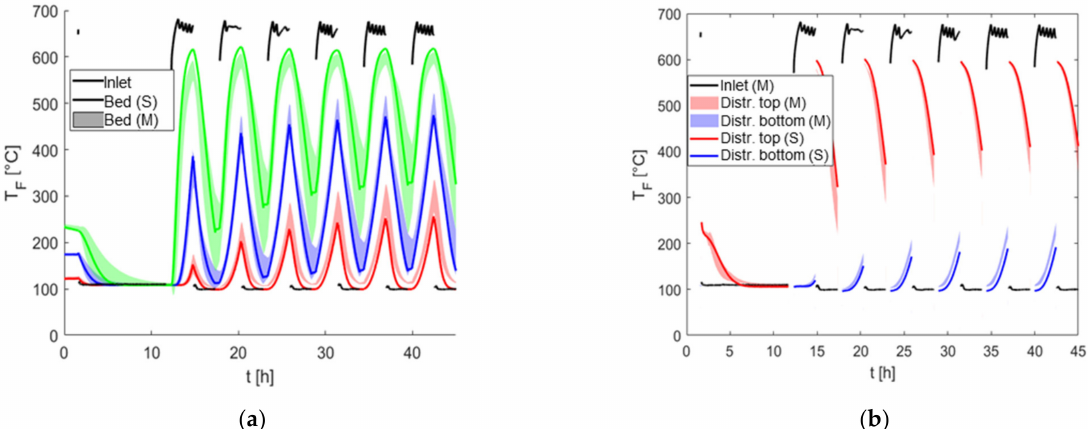
Figure 22. Test T2—Fluid temperature (TF), measurement (M), simulation (S): ( a ) temperature at bed height 0.3 m (red), 0.9 m (blue), 1.5 m (green); ( b ) temperature in the hot-side (top)/cold-side (bottom) manifold.